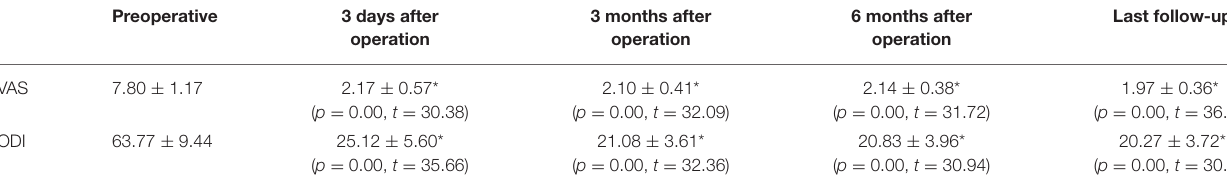
TABLE 1 | The VAS score and ODI of 52 patients before and after operation were compared. Preoperative 3 days after